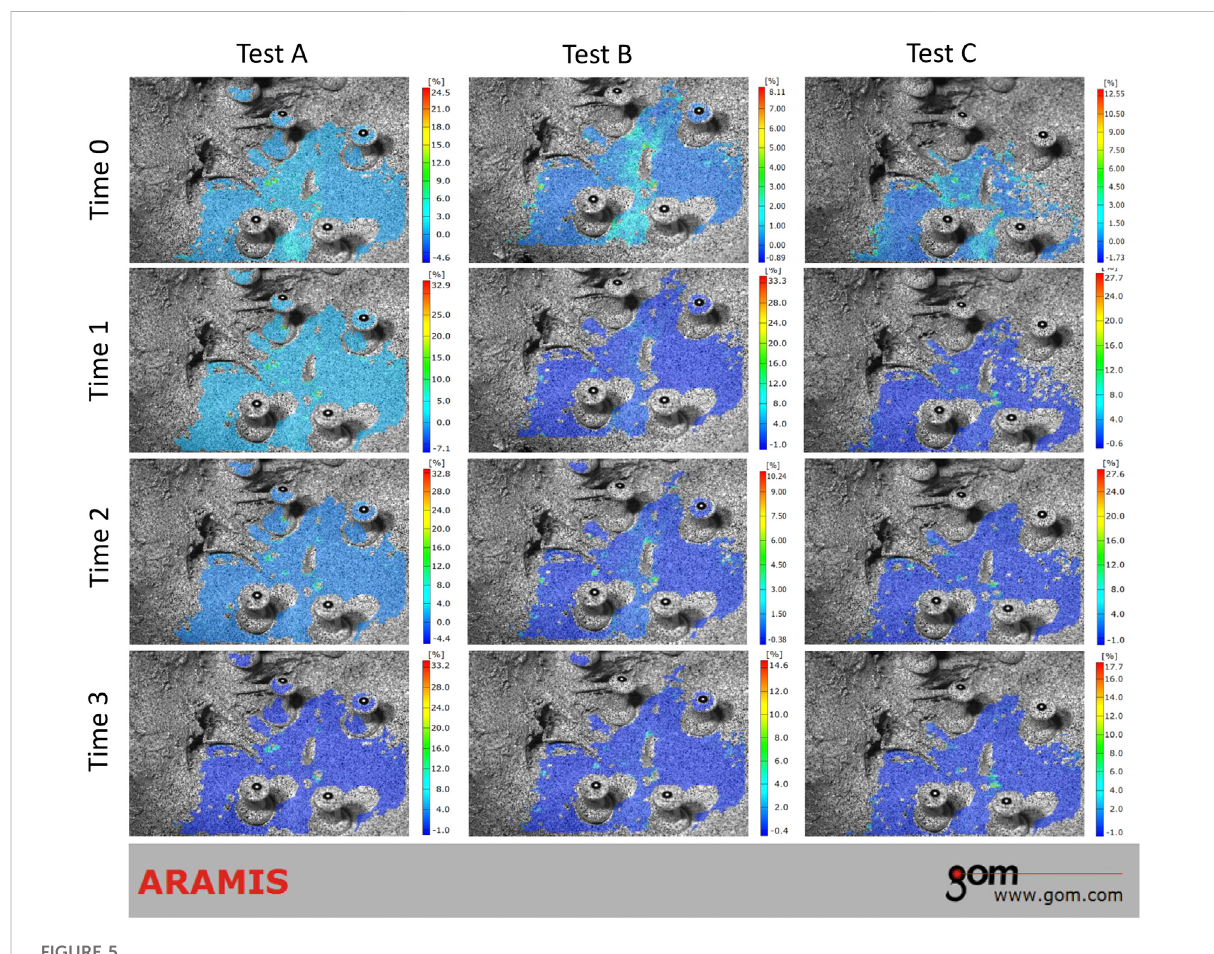
FIGURE 5 Strain trend of stable sacroiliac joint under three tests (unloading phase). Time 0 showed the original condition with the maximum load, which was the same as the ending condition during loading phase. Time 1 and 2 showed the process of unloading. Time 3 showed the ending condition without any